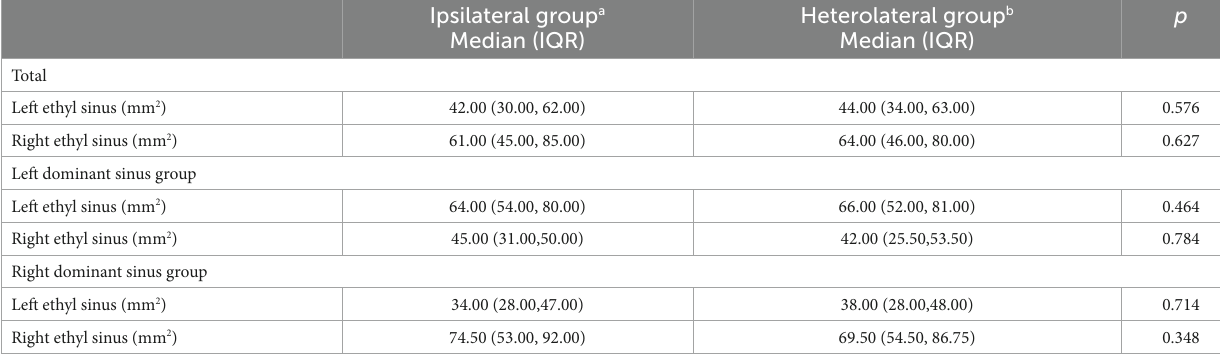
TABLE 3 Comparison of section area of the left and right sigmoid sinus between the ipsilateral group and heterolateral group.